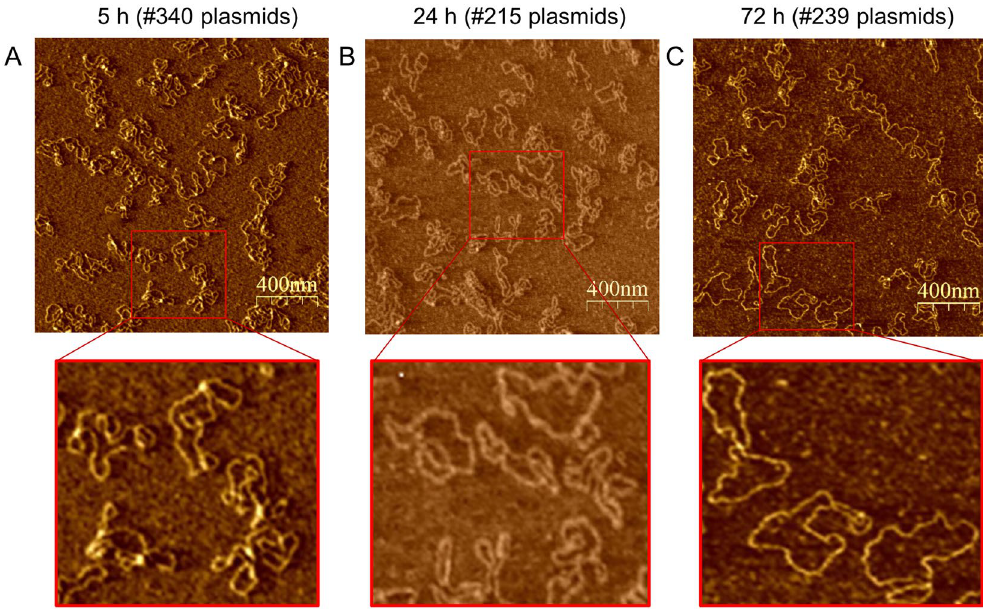
Figure 3. Representative AFM-amplitude images (1.9 µ m scan) of pUC19. Plasmid pUC19 was incubated in aqueous ectoine solution (500 mM) at 22 °C for 5 h ( A ), 24 h ( B ) and 72 h ( C ). For AFM imaging at room temperature, pUC19 DNA was chemically fixed on ultra-smooth mica, which has been pre-silanized with APTES.